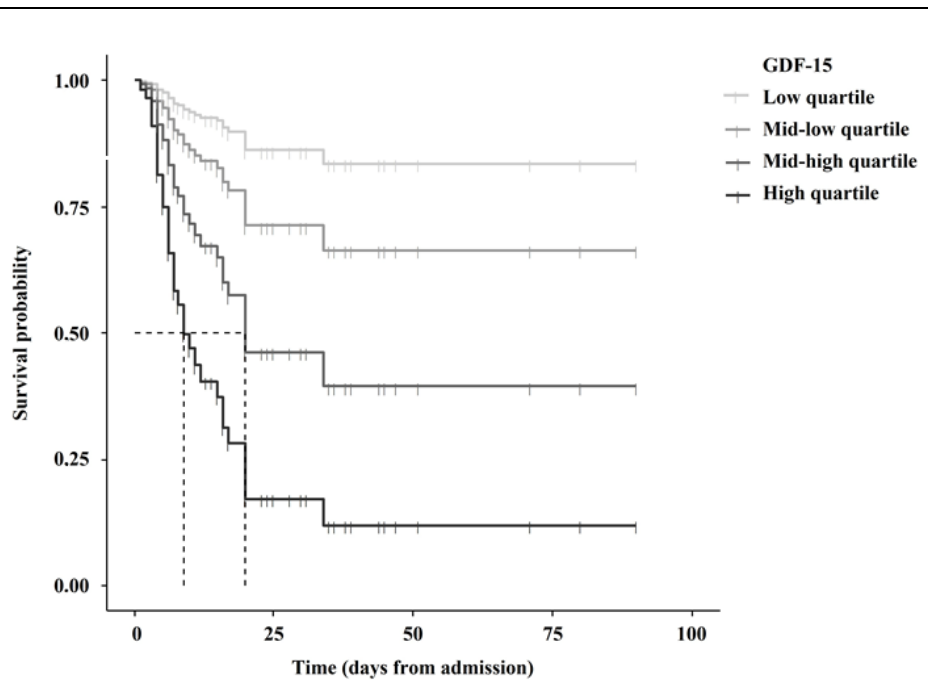
Figure 2. Association between GDF-15 quartiles and survival. Table 2. Multivariate Cox regression model for survival in all patients, stratified by eGFR. Abbre- viations: eGFR, estimated glomerular filtration rate; GDF-15, growth and differentiation factor 15; P/F, ratio of arterial oxygen partial pressure to fractional inspired oxygen.